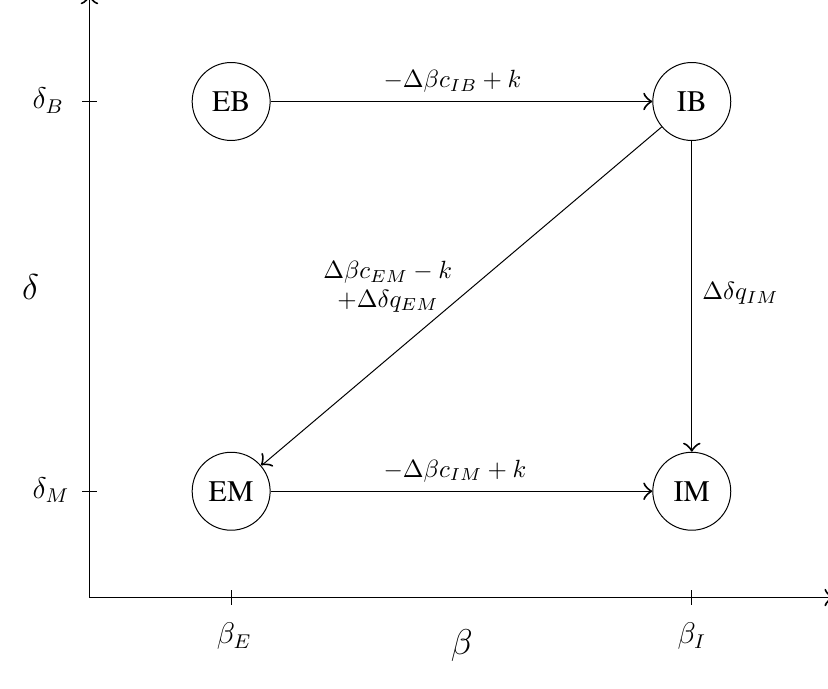
Figure 5. Incentive constraints that are binding in Case